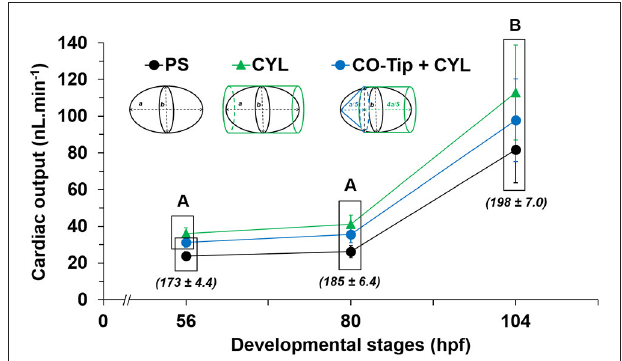
FIGURE 3 | Cardiac output calculations as a function of development in larval mahi as determined by the three ventricular models: Prolate Spheroid, PS; Cylinder, CYL; and Cone Tip + Cylinder, CO-Tip + CYL. Heart rate (beats per minute) data are given in italic and in parentheses. N = 10 for each model at each developmental stage. Data are Mean ± SEM. A box surrounds statistically identical mean values at the same development time ( P > 0.05). Capital letters indicate significant differences across development ( P <